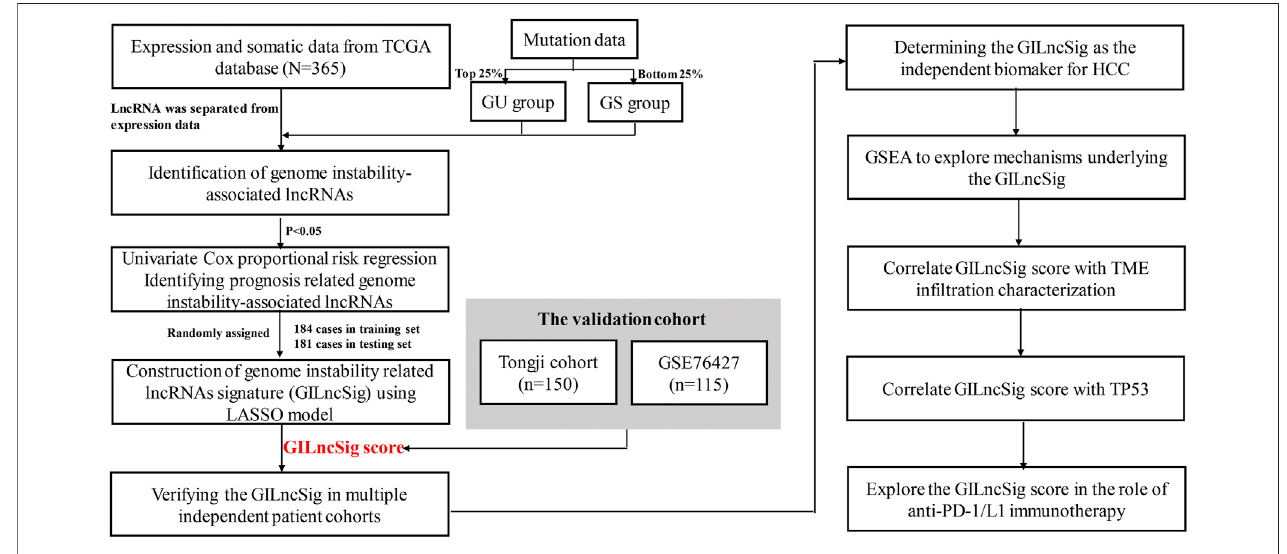
FIGURE 1 | Flow chart of the steps in the performed